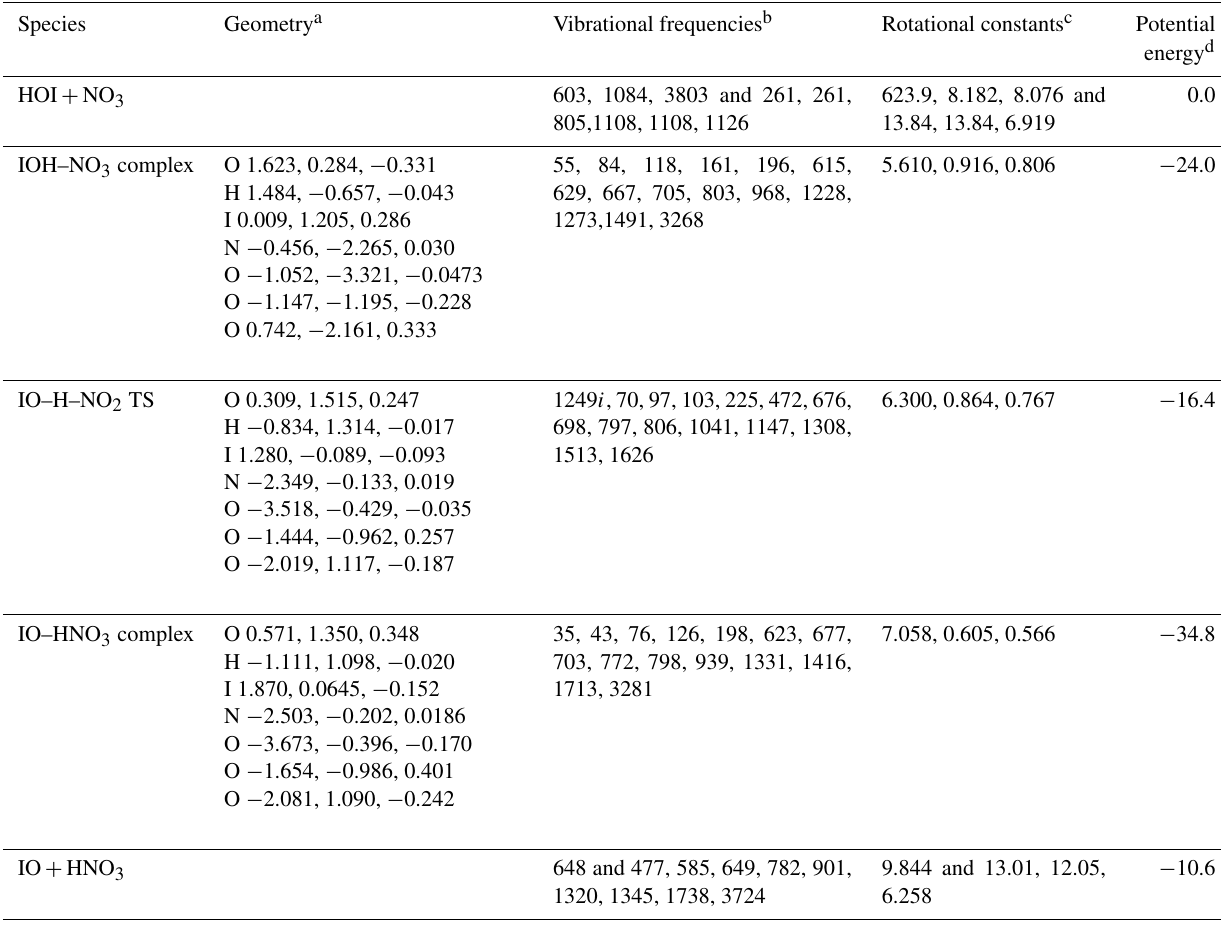
Table 2. Calculated vibrational frequencies, rotational constants and energies of the stationary points and asymptotes on the HOI + NO 3 doublet potential energy